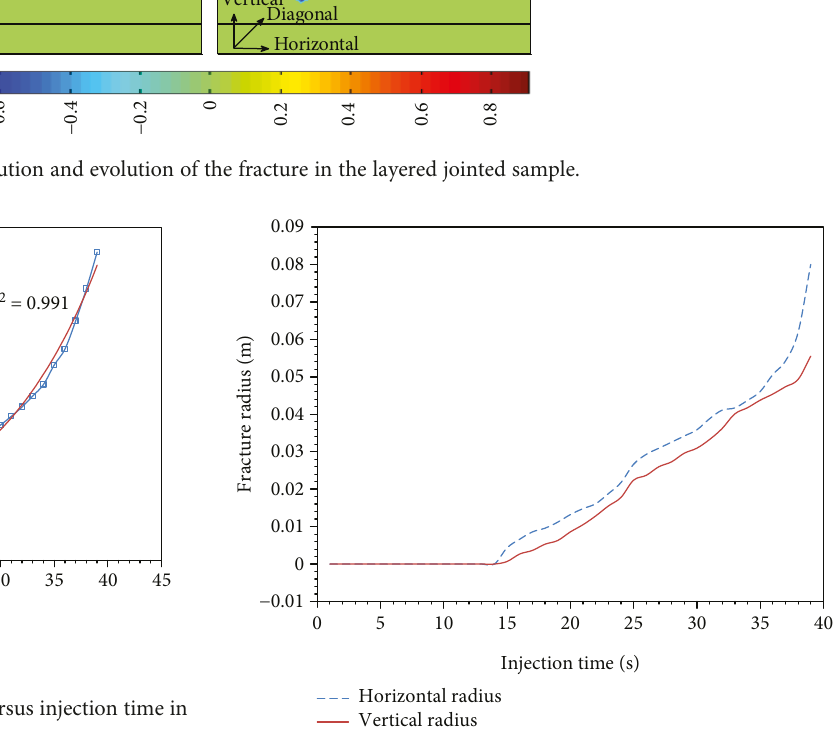
Figure 10: Development of horizontal and vertical fracture radii versus injection time in the layered jointed